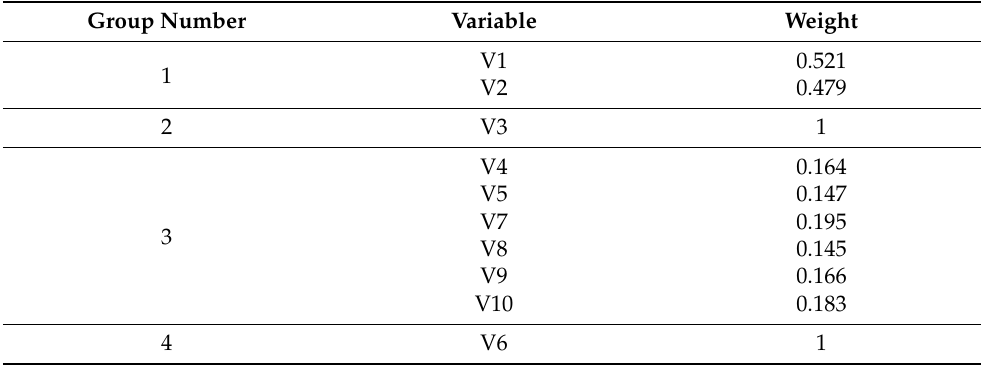
Table 5 lists the weights for variables in four groups. Table 5. Variable